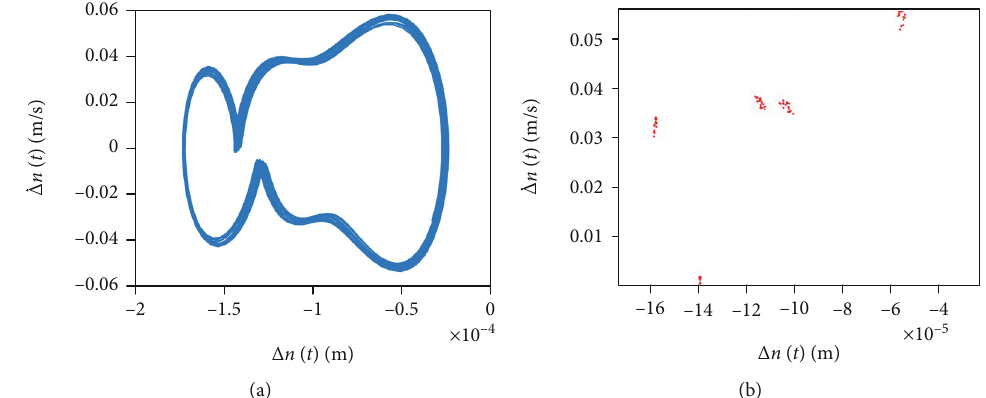
Figure 29: When the rotation speed of the system is 5600r/min: (a) relative displacement velocity and (b) the corresponding diagram of Poincare.